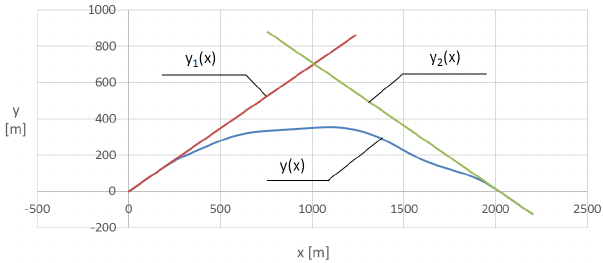
Figure 4: Illustrative section of the railway route in local coordinates system; y ( x ) – the existing course of the route, y 1 ( x ) and y 2 ( x ) – determined main directions of the route.